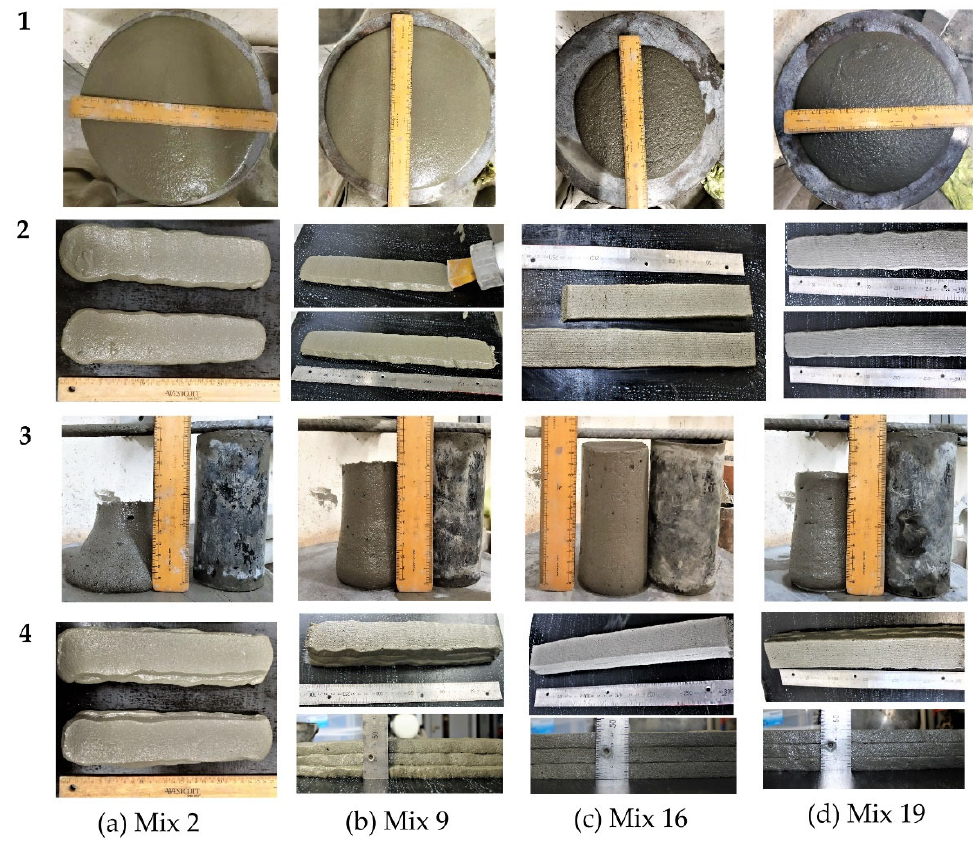
Figure 4. Measurement of slump flow and slump along with printed filaments corresponding to ( a ) mixture no. 2; ( b ) mixture no. 9; ( c ) mixture no. 16; and ( d ) mixture no. 19.